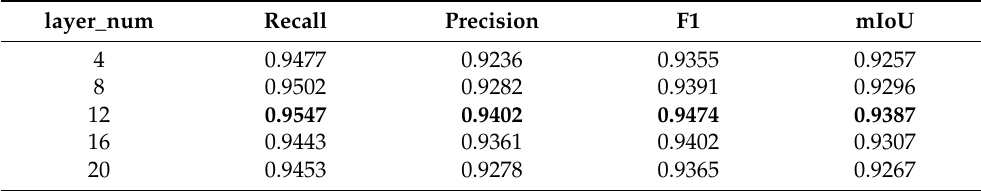
Table 9. Building extraction accuracies under different layer_num settings when head_num = 8. The highest accuracy is displayed in